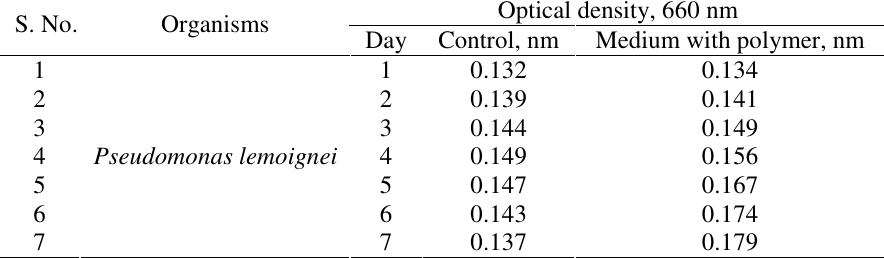
Optical density, 660 nm